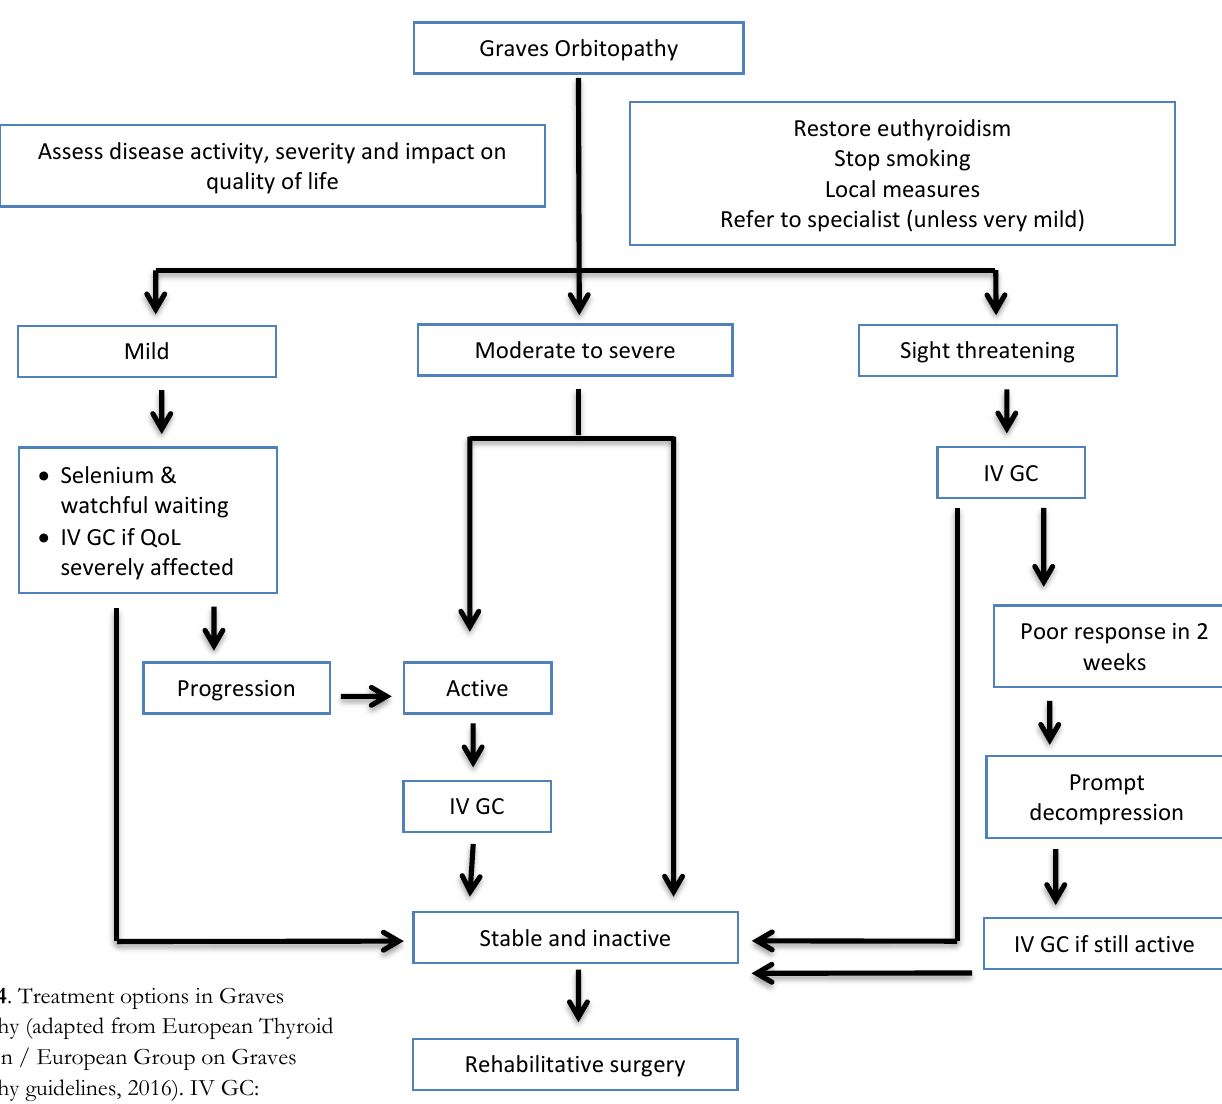
Graves Orbitopathy